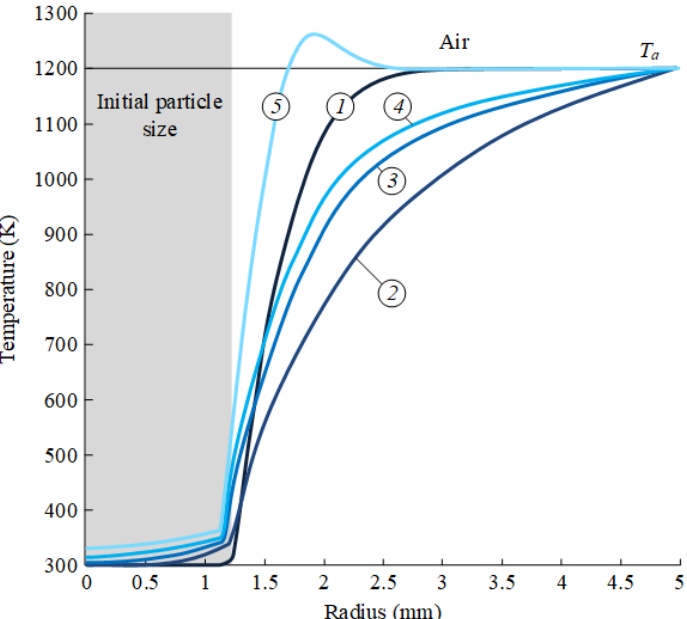
Figure 22. Temperature profiles in the fuel particle/air system at T a = 1200 K, r p = 1.25 mm, µ 4 = 48% at different time points [190]: 1 — t = 0.1 s; 2 — t = 0.386 s; 3 — t = 0.77 s; 4 — t = 1.16 s; 5 — t = 1.55 s.